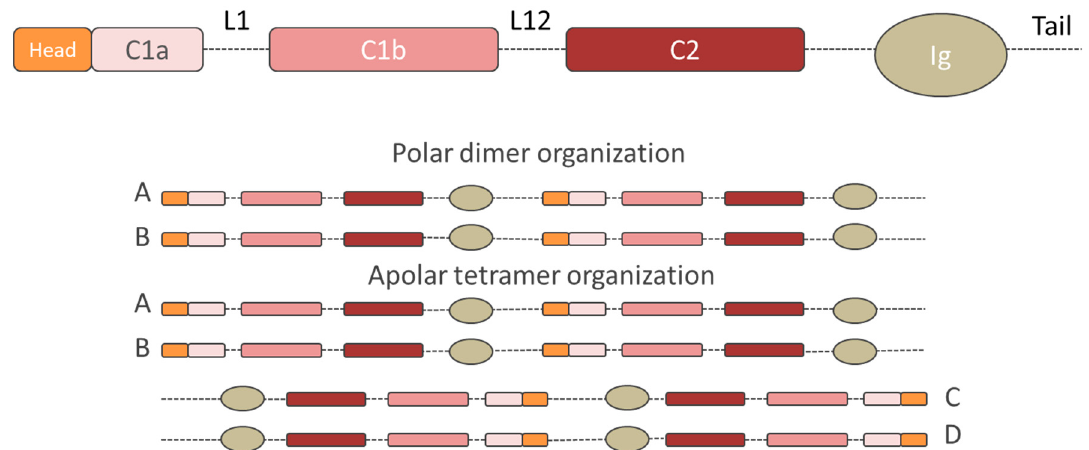
Figure 1. The general structure of lamins. From top to bottom: single chain structure, dimer organization and tetramer structure. The structural organization of human lamins consists of head, central rod, and C-terminal tail containing the globular Ig-like domains. Dotted lines represent unstructured regions. The central rod domain is divided into the three coiled coil domains C1a, C1b, and C2, separated by the flexible linkers L1 and L12. Two single chains associate with their coiled coil domains to form parallel (polar) homodimers, which bind other identical homodimers via head-to-tail interactions thus forming a polar structure (chain A and chain B). In line with other IF structures, the homodimers interact laterally with other identical homodimers arranged in an antiparallel way. The resulting structure is an antiparallel (apolar) tetrameric filament (chain A, chain B, chain C, and chain D).